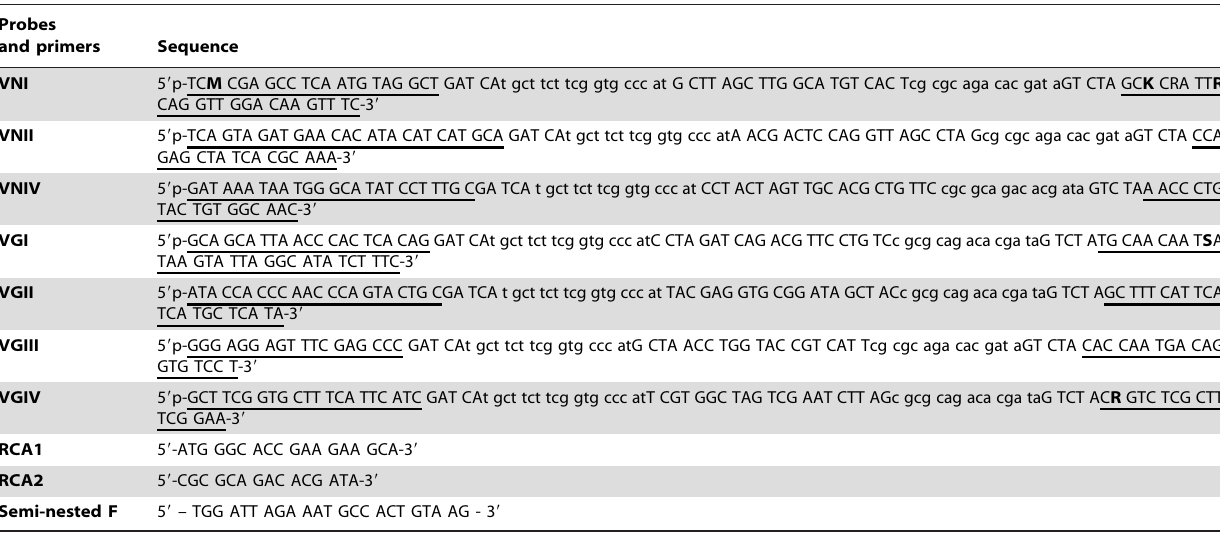
Table 2. Padlock probes and padlock probe primers.